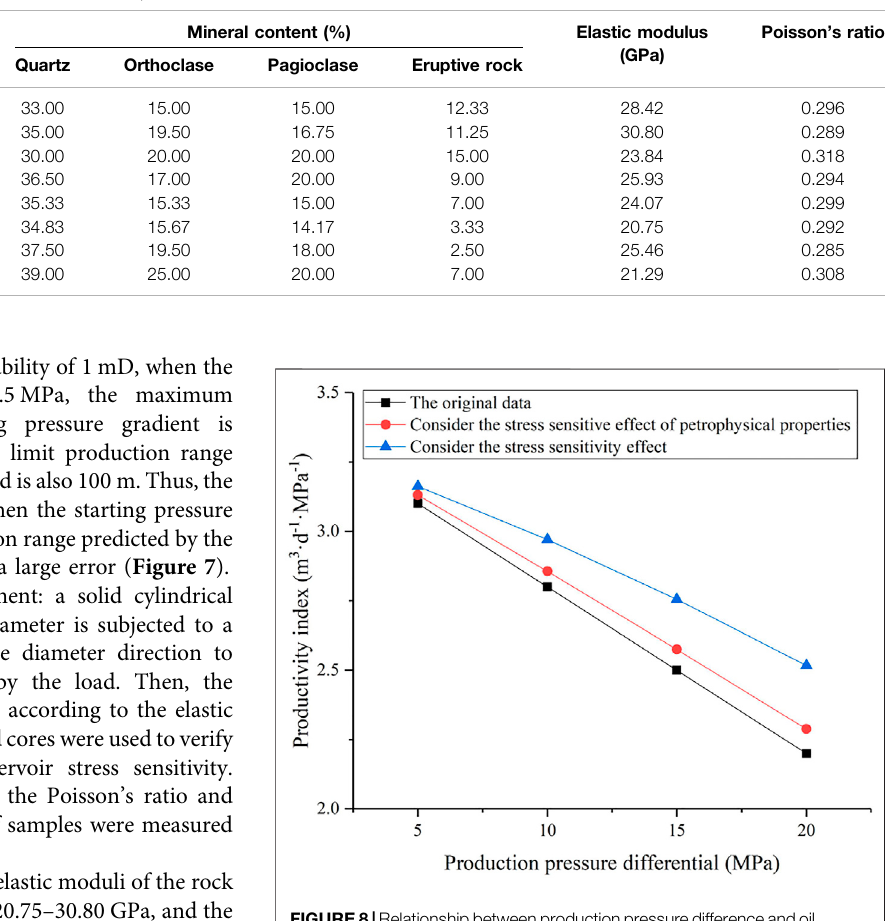
TABLE 2 | Test results of mineral composition and rock mechanical parameters.